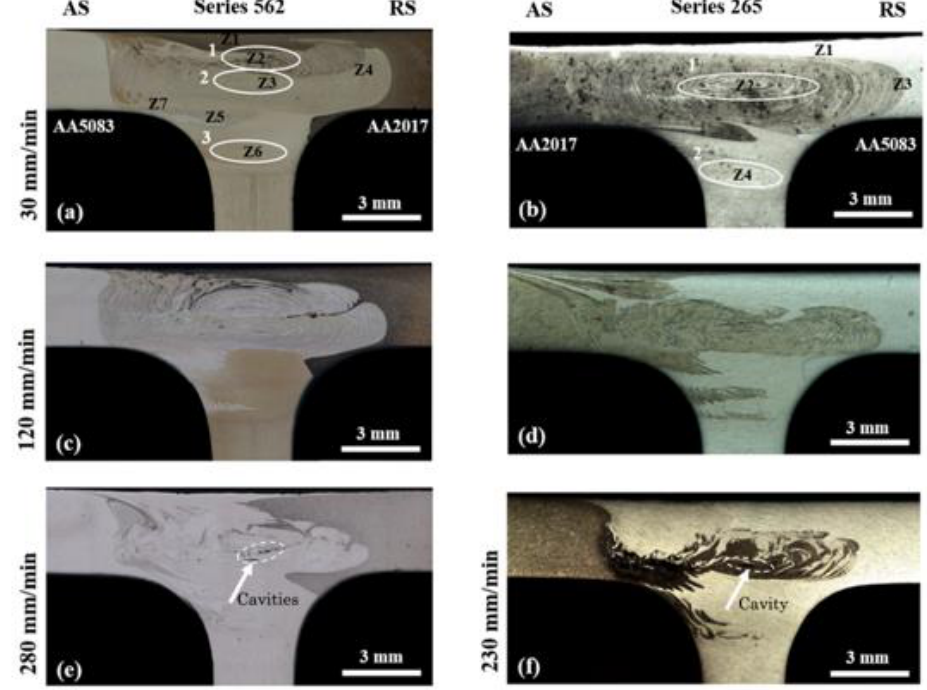
Figure 5. Cross-section macrographs of the three dissimilar materials weld series: ( a ) 562-30, ( b ) 265-30, ( c ) 562-120, ( d ) 265-120, ( e ) 562-280, and ( f ) 265-230. Table 4. Chemical composition in the various zones of both the 562-30 and 265-30 series (wt.%). Welds Series Zone Mg